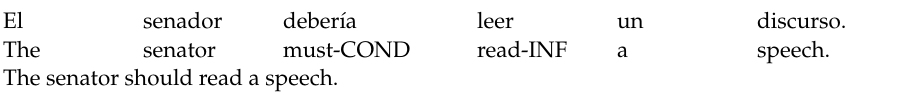
Figure 9. Derivation of ‘the senator should read a speech’ according to [21]